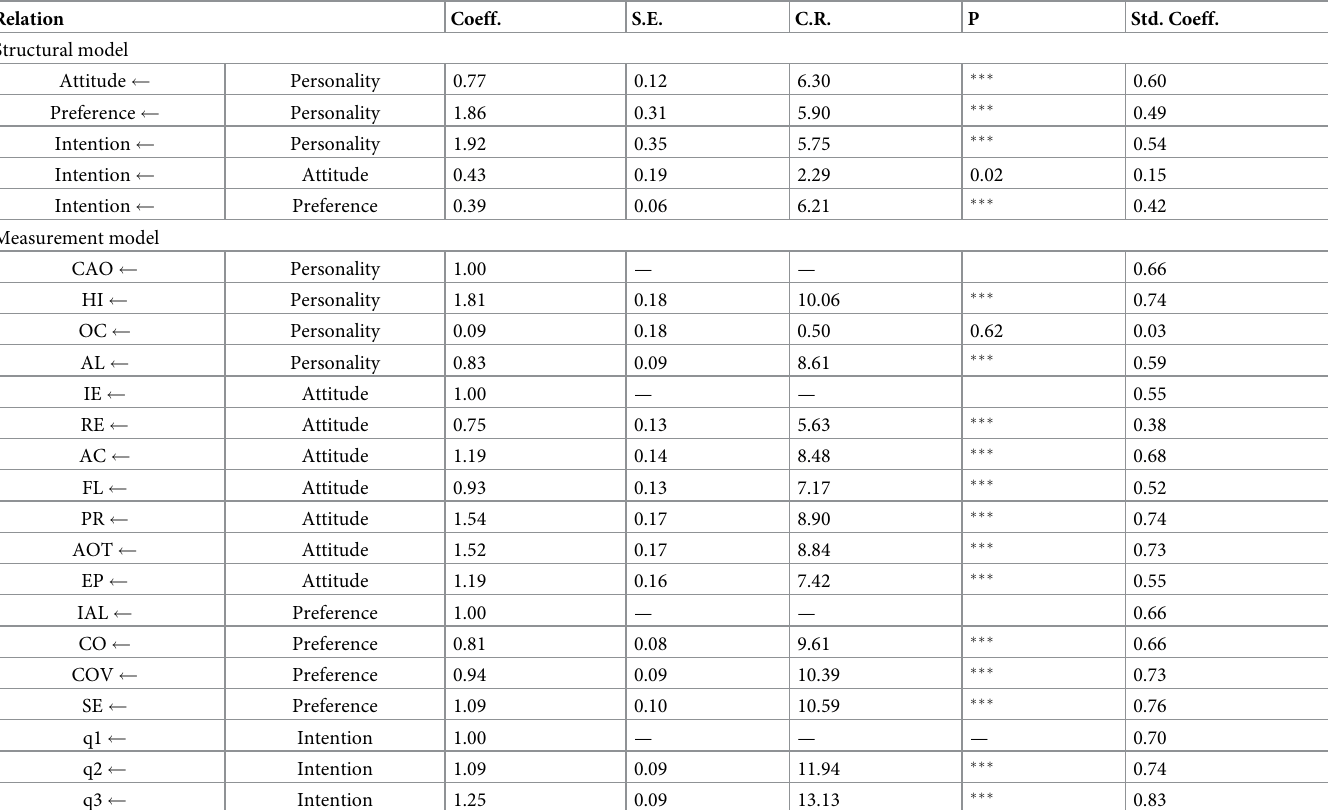
Table 4. Results of model path coefficients. Relation Coeff.